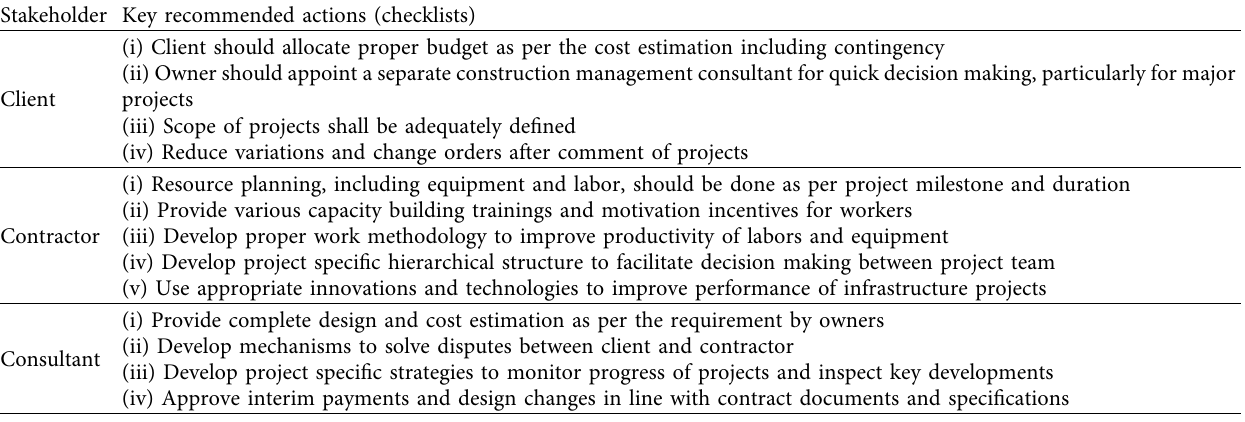
Table 9: Critical recommended actions to reduce cost overrun and